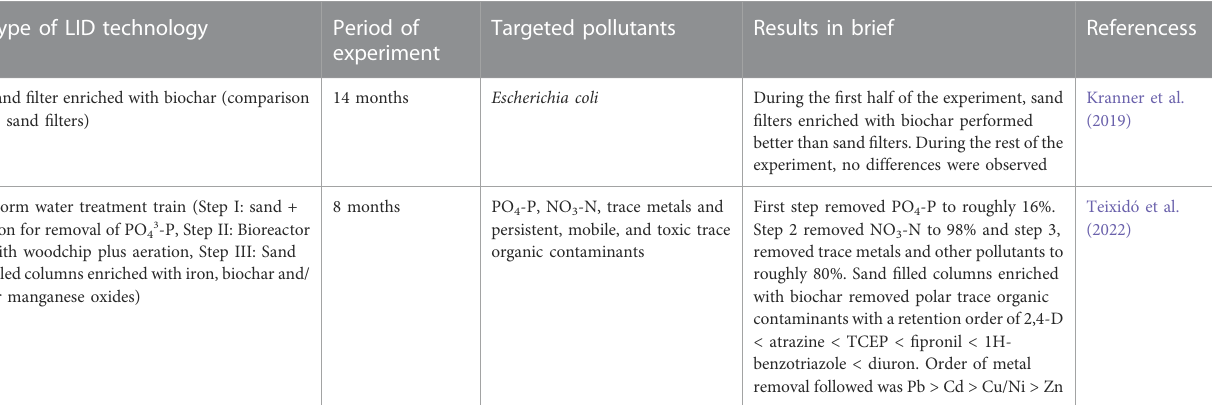
TABLE 2 Low Impact Development facilities including biochar as fi lter